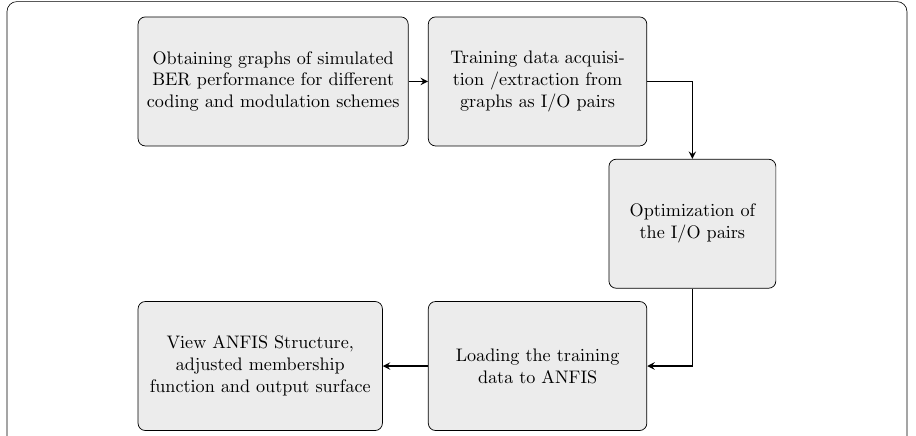
Fig. 2 Neuro-Fuzzy-based system model flow chart. A flow chart which describes neuro-fuzzy system which enhances the adaptability capacity of the adaptive code modulation